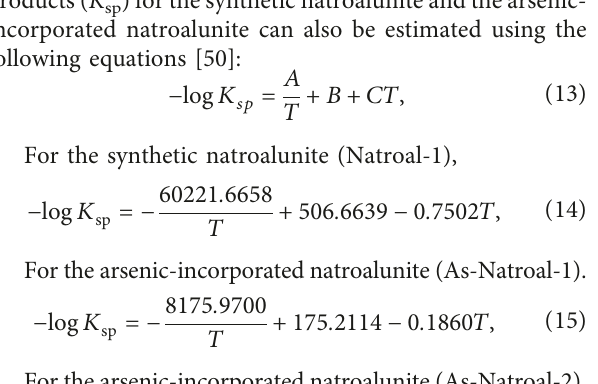
Table 1: Analytical data and solubility product of the synthetic natroalunite [Na Temp ( ° C) Initial pH Time (h)